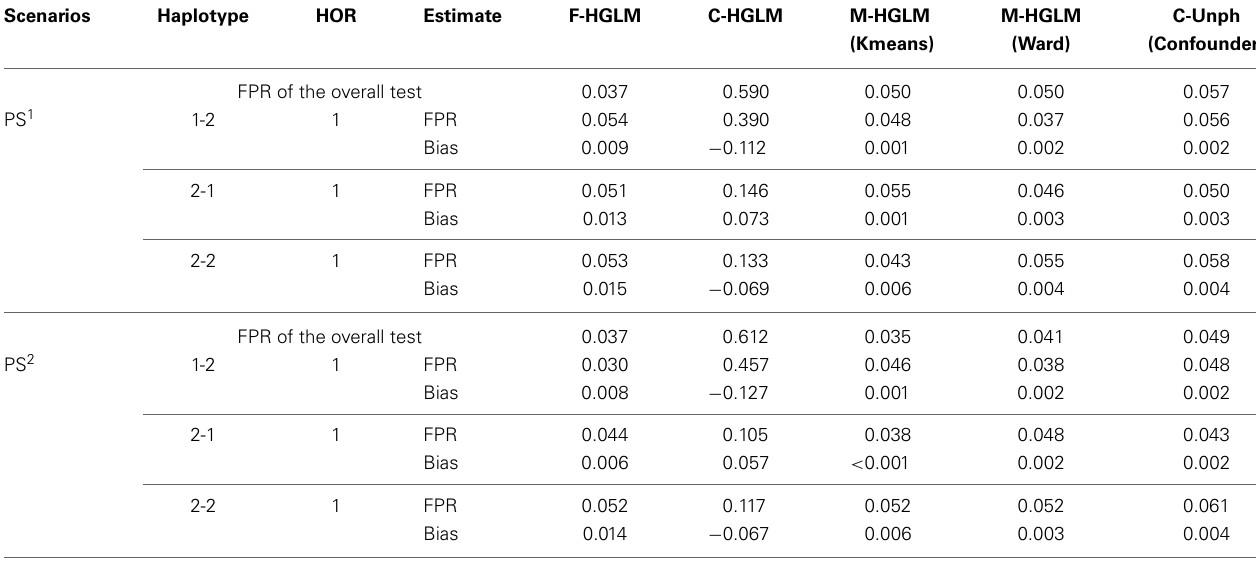
Table 6 | False positive rates of the modified HGLM (M-HGLM) with clustering methods (Kmeans and Ward) in the presence of population stratification ( n 1 = 500 and n 2 = n 3 =